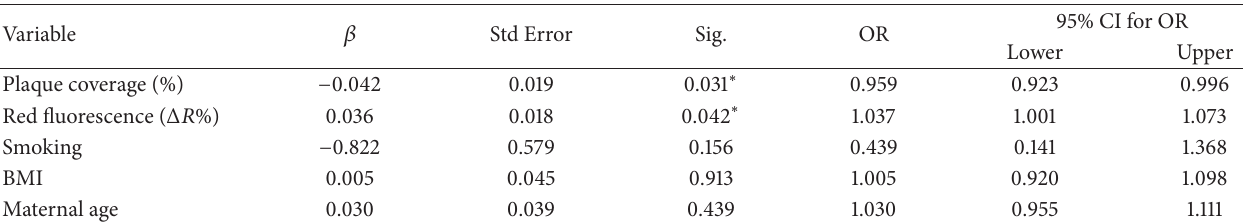
95% CI for OR Lower Upper